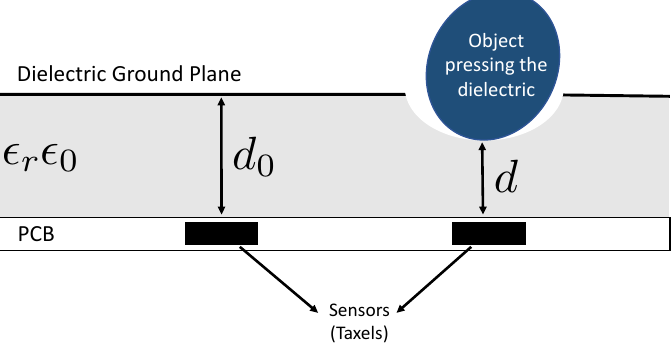
Figure 2. Printed circuit boards (PCBs) covered by the skin, deformed under contact